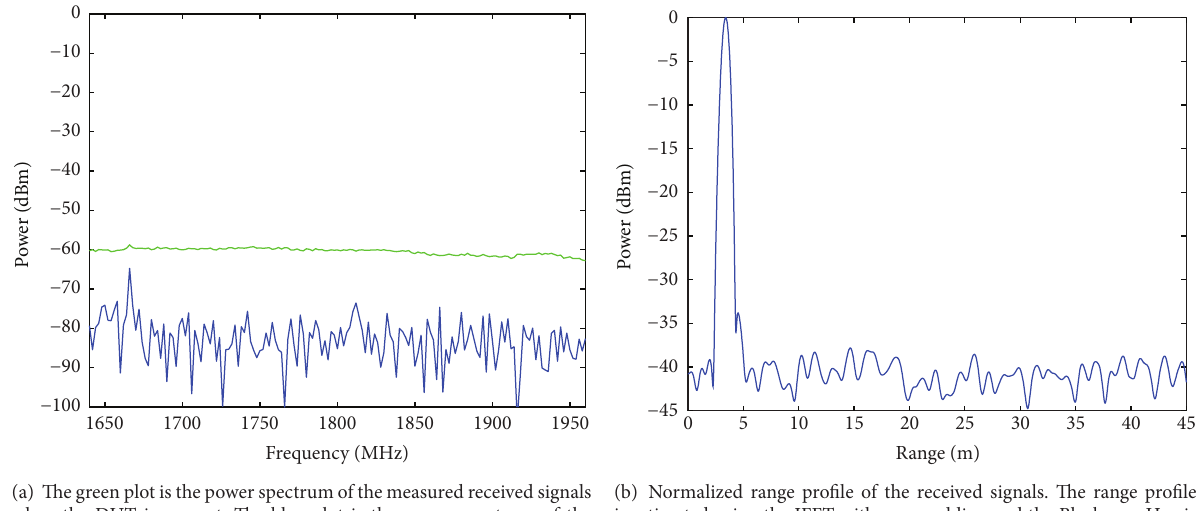
Window function